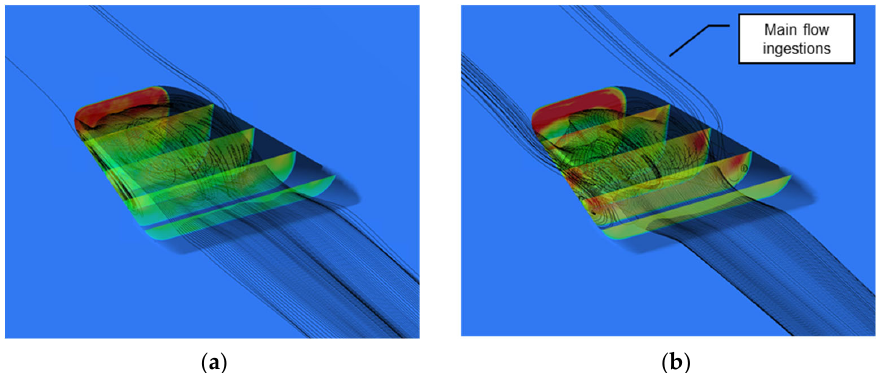
Figure 17. Streamline distributions inside the cooling hole ( a ) without and ( b ) with upstream turbulent boundary layer when the blowing ratio is